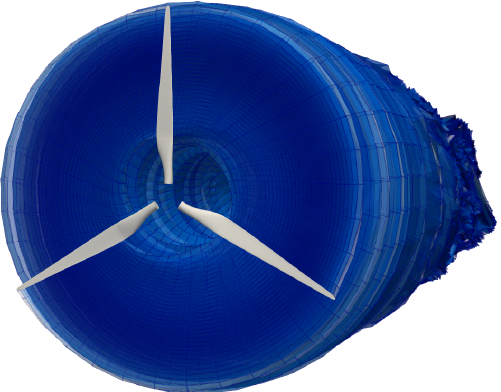
Figure 2. Panel method simulation results of the UNAFLOW rotor and its wake.